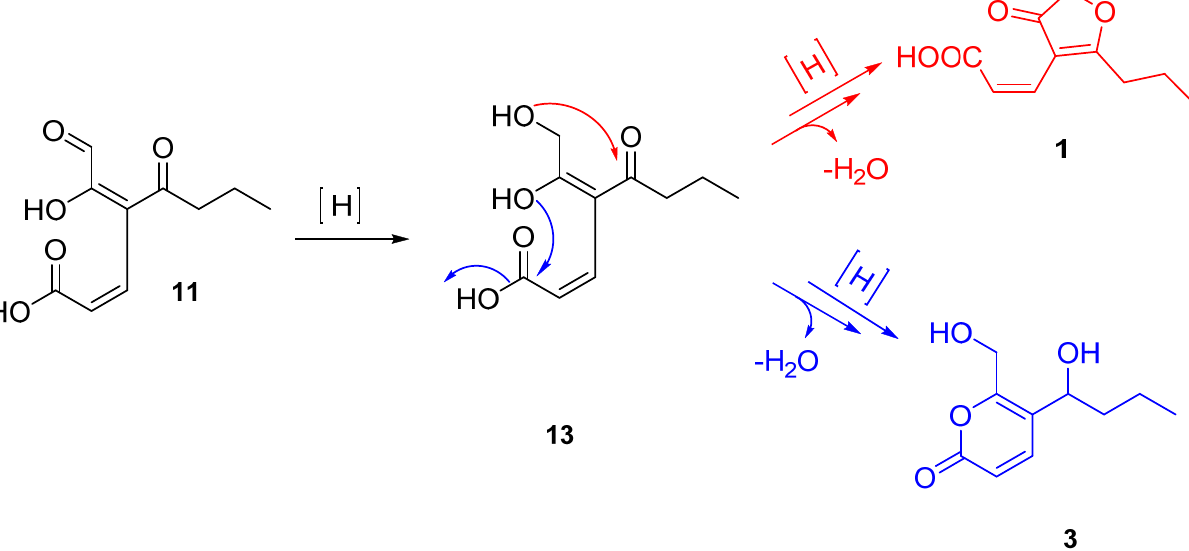
Figure 7. Proposed biosynthesis of (2 Z )-cillifuranone ( 1 ) (red) and taiwapyrone ( 3 ) (blue).